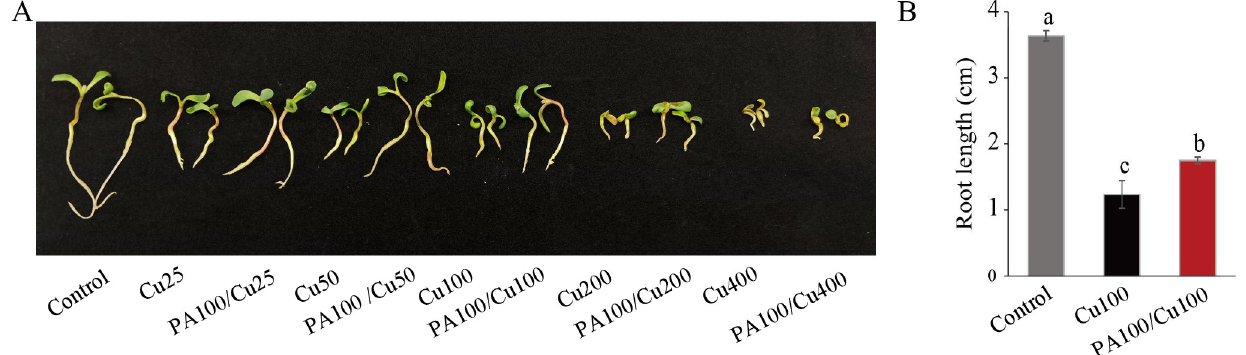
Fig 4. Proanthocyanidins (PAs) improved Medicago truncatula (R108) seedling growth under excess Cu conditions. (A) The phenotype of seedlings after 8 d of different concentrations of Cu treatment or pretreated with PAs. (B) PAs increased root length under Cu stress (n = 20). Cu 25, 50, 100, 200, 400 represents 25, 50, 100, 200, 400 mg L -1 CuSO 4 •5H 2 O, respectively. PA100: 100 mg L -1 PAs pretreatment. Means ± SE of three biological replicates. Significant differences ( p � 0.05) are denoted by different lowercase letters.